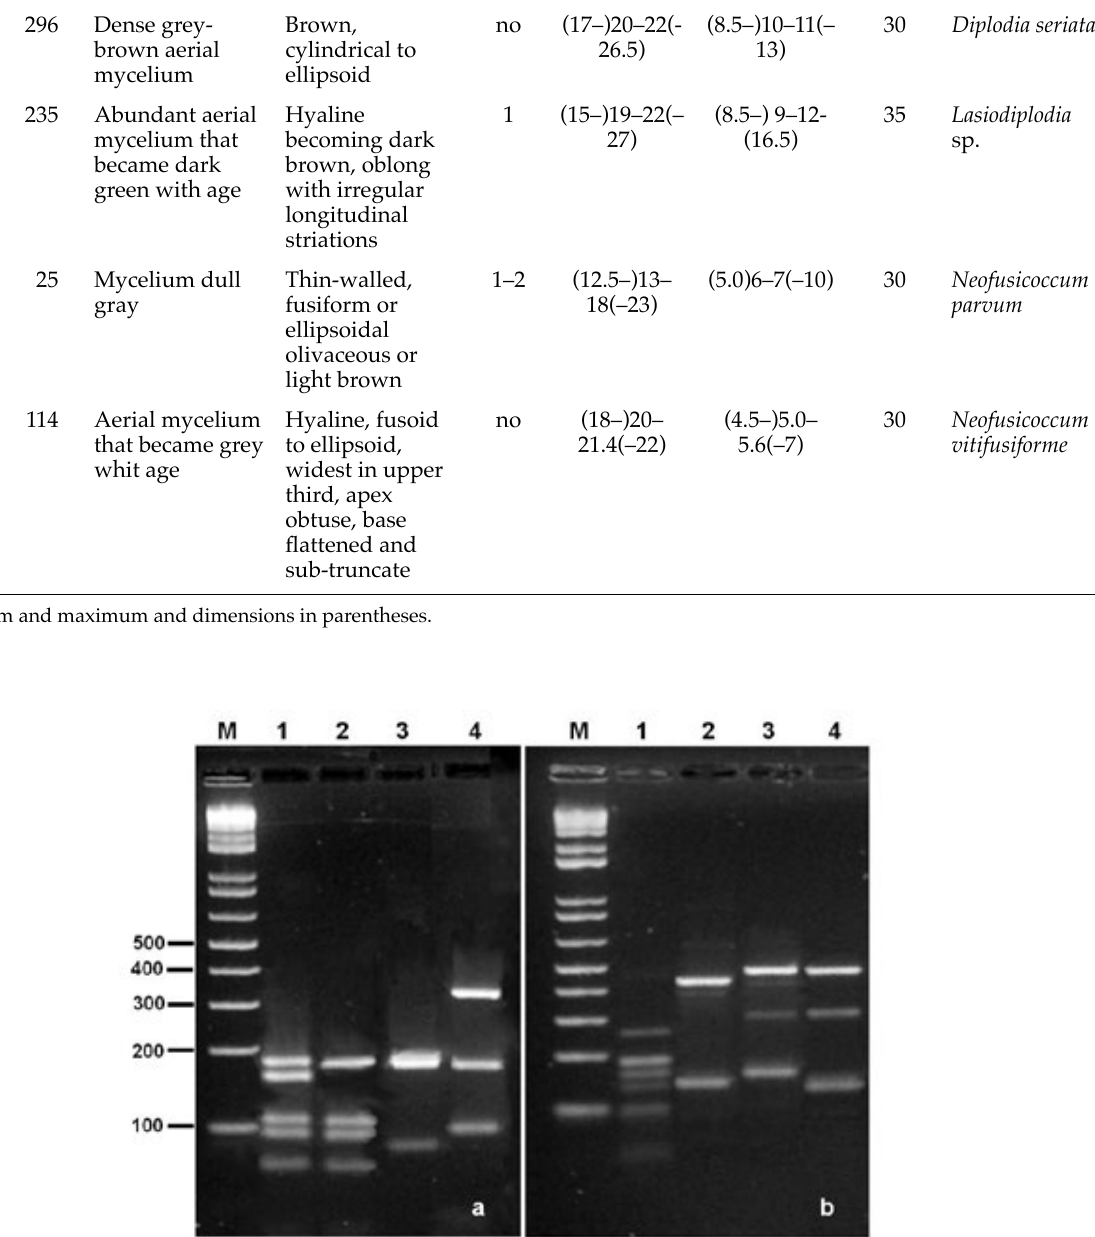
Figure 2. Restriction profiles with Cfo I (a) and Hae III (b) of the ITS PCR products of N. parvum (lane 1), N. vitifusiforme (lane 2), D. seriata (lane 3) and Lasiodiplodia sp. (lane 4). M, 1 Kb plus DNA ladder